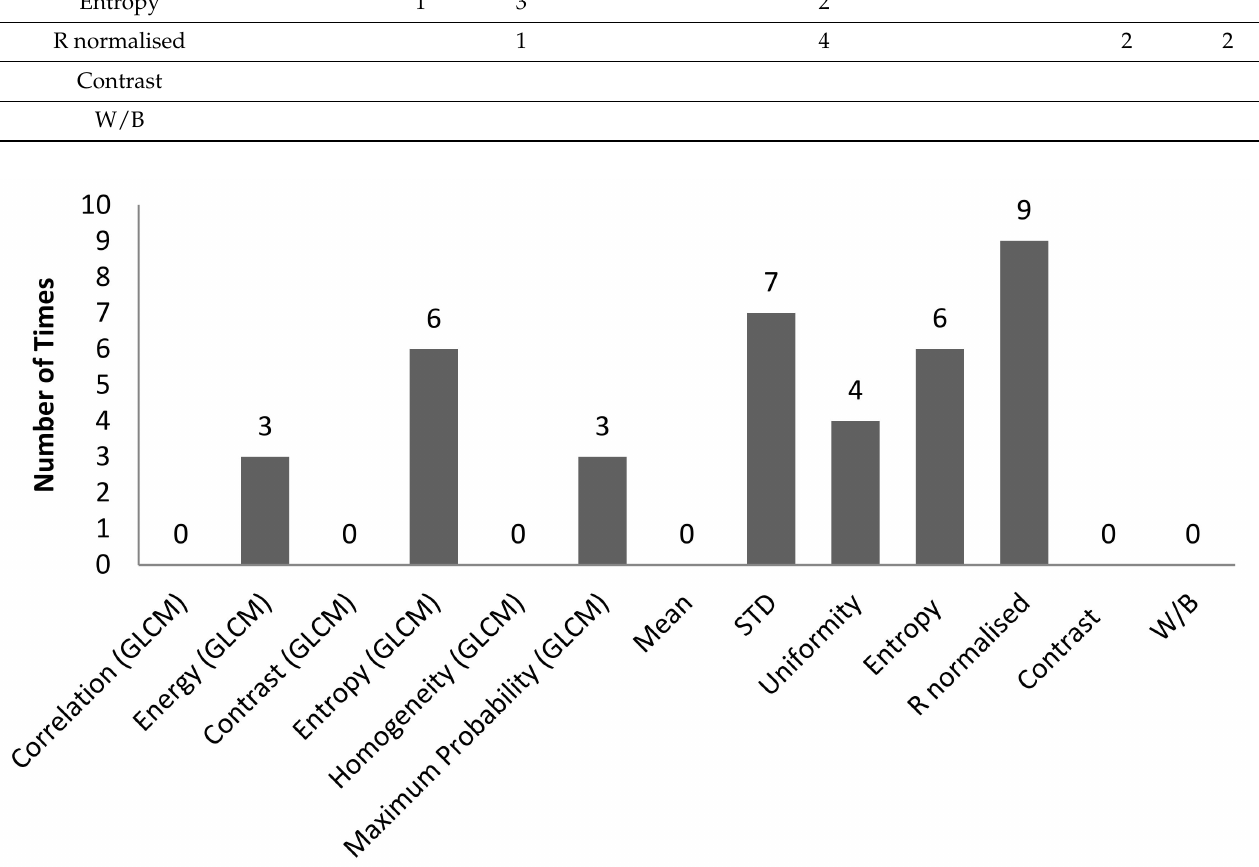
Figure 8. Bar chart showing the number of times a characteristic feature was involved in a correlation with R 2 ≥ 0.7 for an illumination angle of 30 ◦ for experimental setup